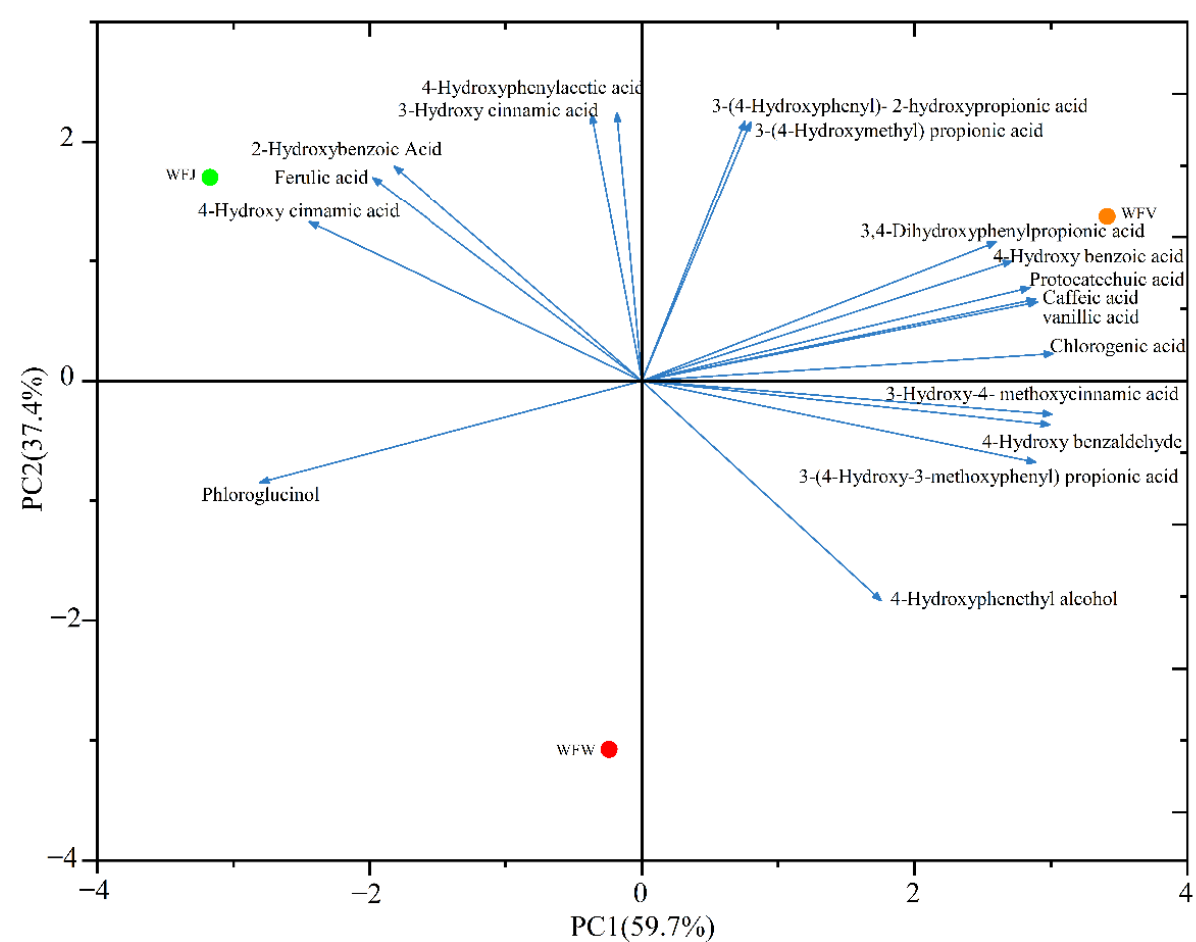
Figure 1. Principal component analysis of the polyphenolic compounds in the fermentation processes. Table 6. Antioxidant activity of wolfberry fruit vinegar in the fermentation processes.